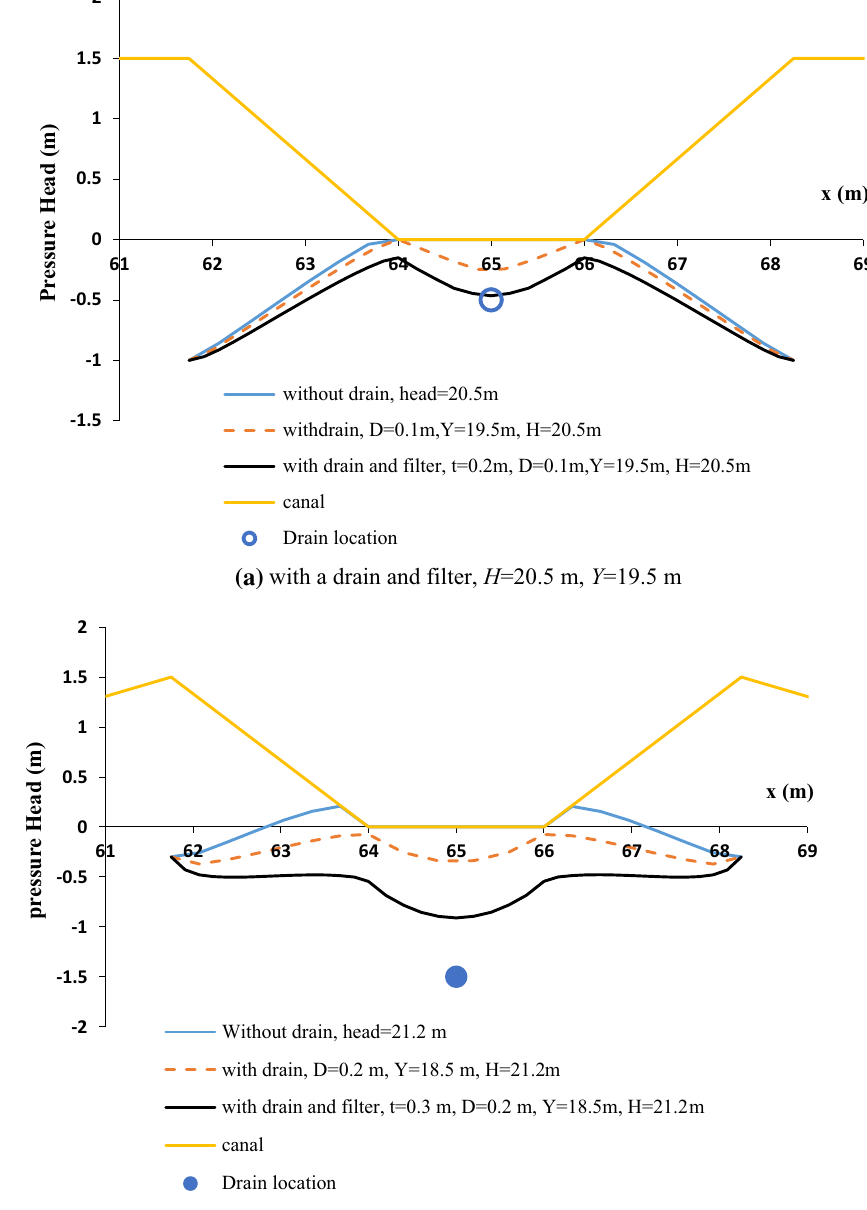
Fig. 14 Hydrostatic pressures on a canal a with a drain and filter, H = 20.5 m, Y = 19.5 m, b with a drain and filter, H = 21.2 m, Y = 18.5